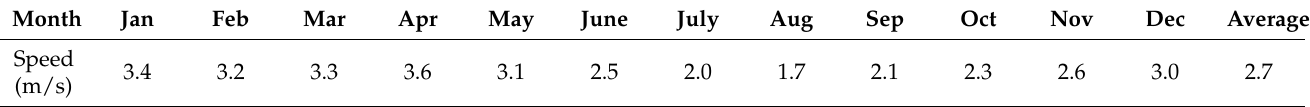
Figure 5. Topographic map of the study case. Table 7. The average monthly wind speed for successive years.